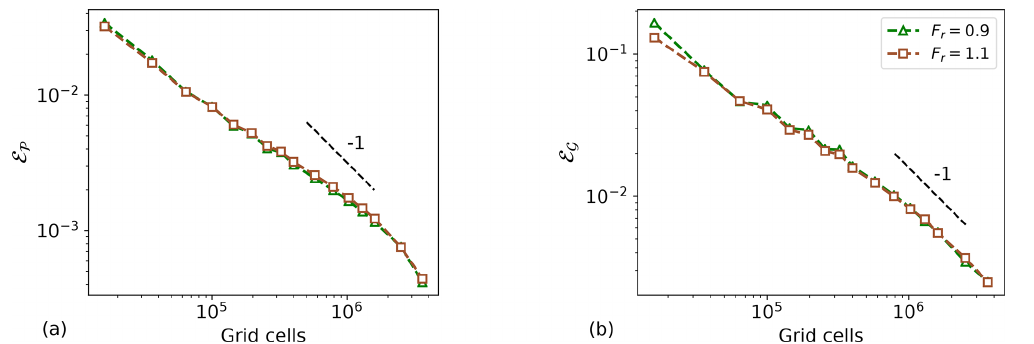
Figure C1. (a) Cost function and (b) power gain relative error between a grid with resolution H/ 4 and coarser grids in sub- and supercritical flow